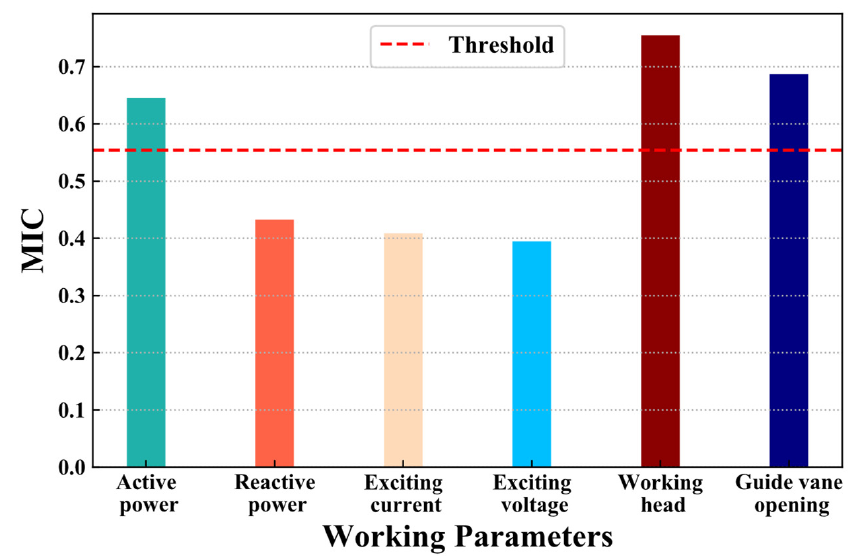
Figure 8. MIC between swing and working parameters.